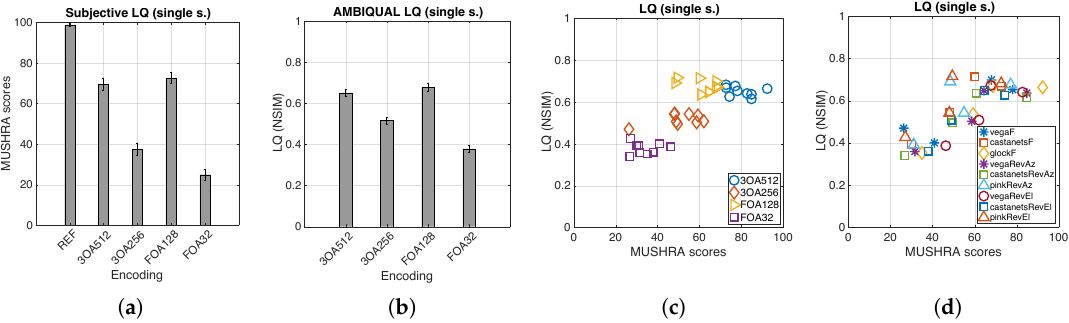
Figure 11. Listening quality-subjective vs. AMBIQUAL results for single point audio sources: ( a ) aggregated subjective results and ( b ) AMBIQUAL quality predictions by encoding scheme (mean values with 95% confidence intervals shown) and scatter of subjective scores vs. AMBIQUAL results by encoding scheme ( c ) and by sample type ( d